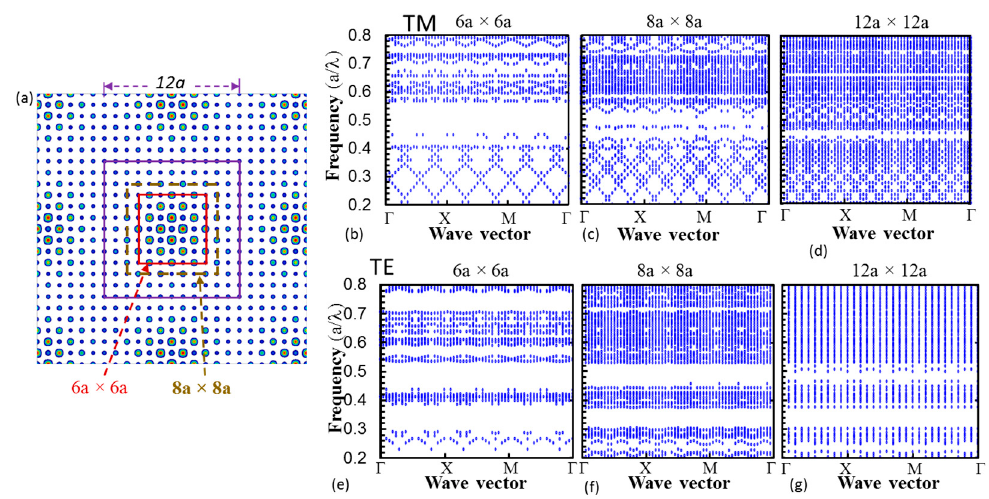
Figure 1. ( a ) Simulated 8-bean interference pattern with a threshold I th = 0.35%Imax. The purple, gold and red squares indicate the size of 12a × 12a, 8a × 8a, and 6a × 6a (the lattice constant a = Λ 1), respectively, that was used as a unit cell in Si graded photonic super-crystals (GPSCs). ( b – d ) Simulated photonic band structures in transverse magnetic (TM) modes for Si GPSCs with a unit cell of 6a × 6a, 8a × 8a, and 12a × 12a, respectively. ( e – g ) Simulated photonic band structures in transverse electric (TE) modes for Si GPSCs with a unit cell of 6a × 6a, 8a × 8a, and 12a × 12a, respectively.